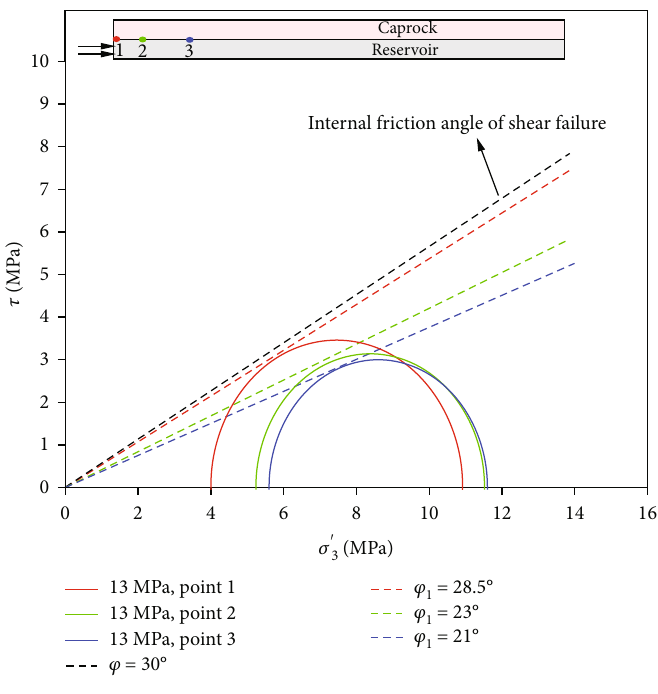
Figure 28: Mohr ’ s circle of stress.